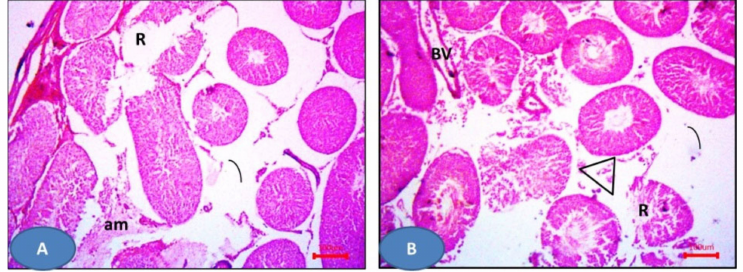
Figure 13. Photomicrographs of sections of the testis: ( A , B ) 6d and 6f respectively showed the ruptured seminiferous tubules (R) with distorted Leydig cells (triangles). Notice the dilated blood vessels (BV) and the amyloid substance (am). H&E ×